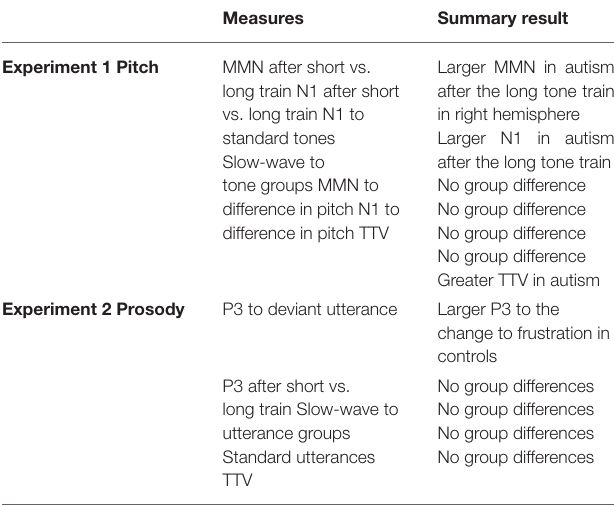
TABLE 2 | A summary of the ERP findings from the responses to changing pitch (Experiment 1) and changing prosody (Experiment 2). Measures Summary